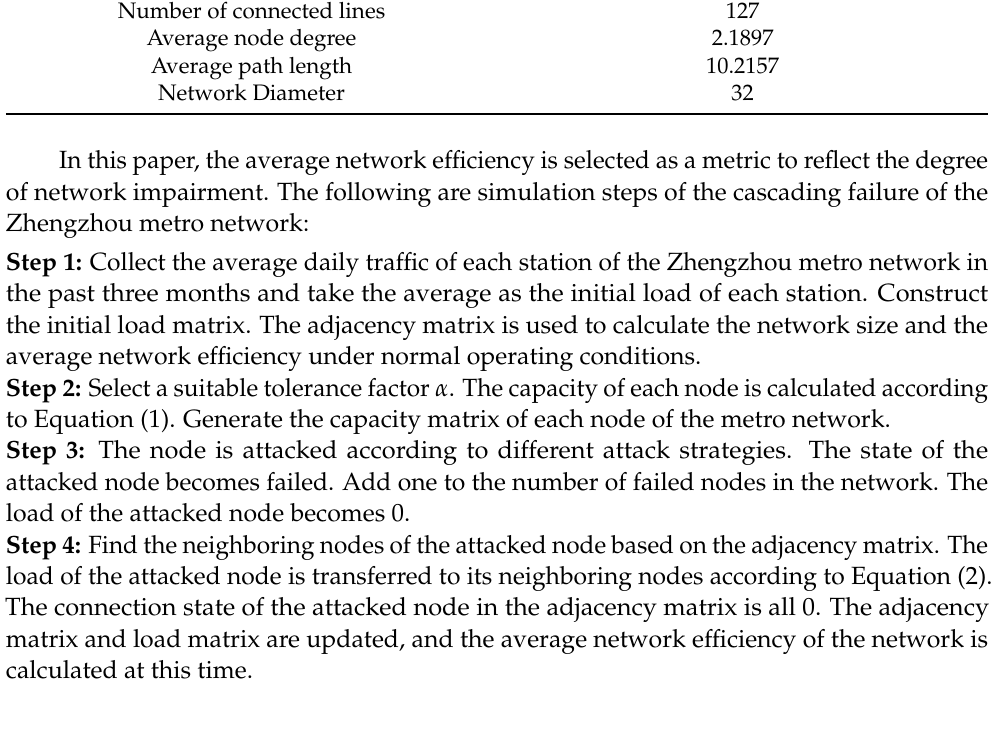
Table 2. Zhengzhou metro network characteristics index.